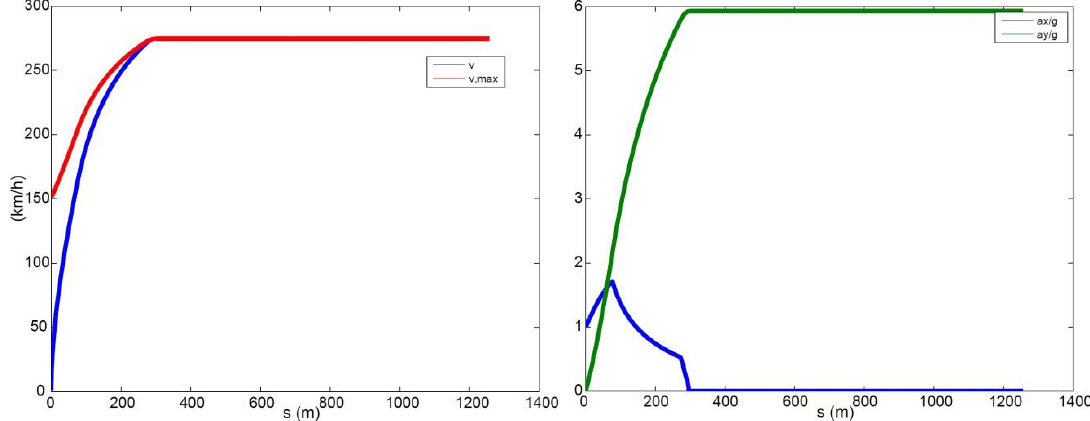
Figure 6. Circumference, aerodynamics, R = 100 m: (left) speed and (right) accelerations with respect to 𝑠 .